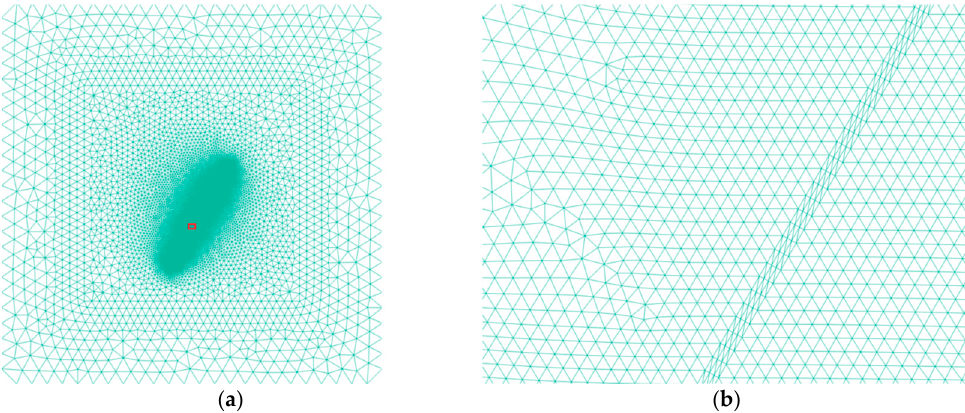
Figure 3. ( a ) Discretization of the entire numerical domain; ( b ) Refined mesh around the fault (zoom of the red rectangle at left).